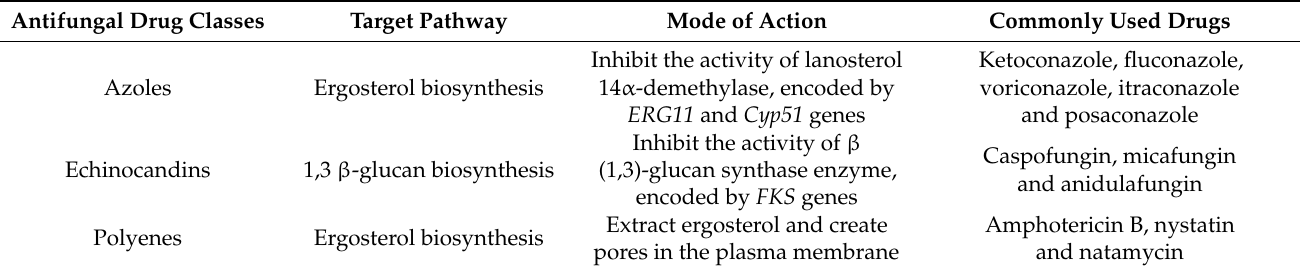
Table 1. Major antifungal drugs and their cellular